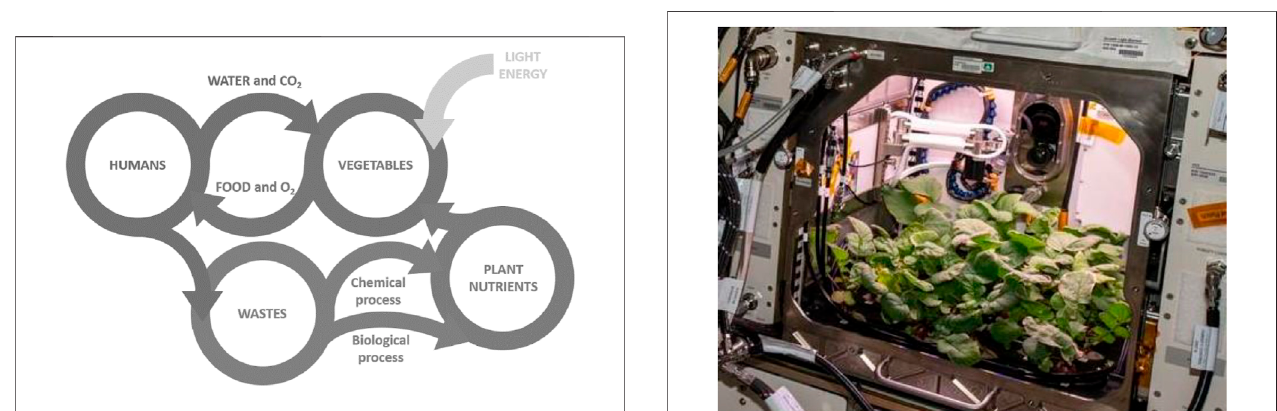
Frontiers in Astronomy and Space Sciences |